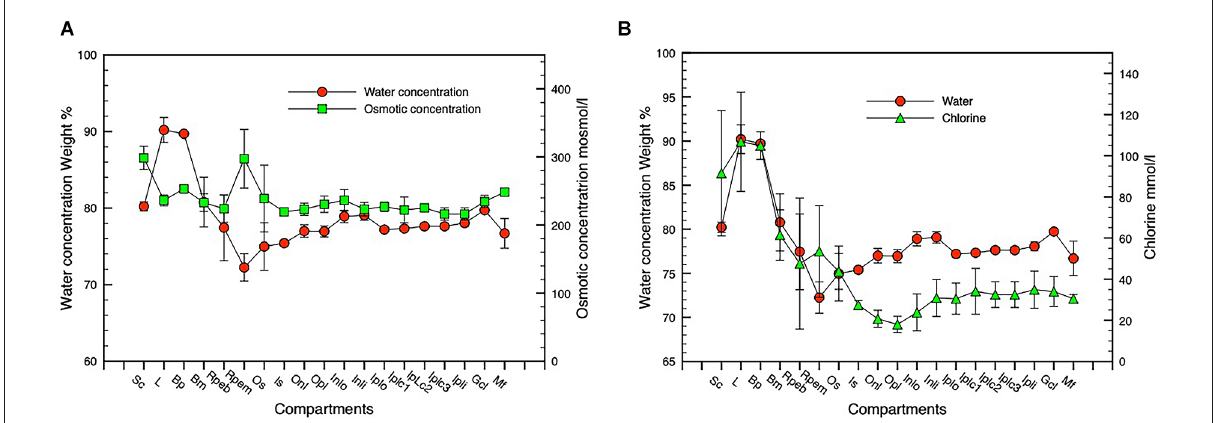
( Figure 8I ). Figure 8B shows a light micrograph of an